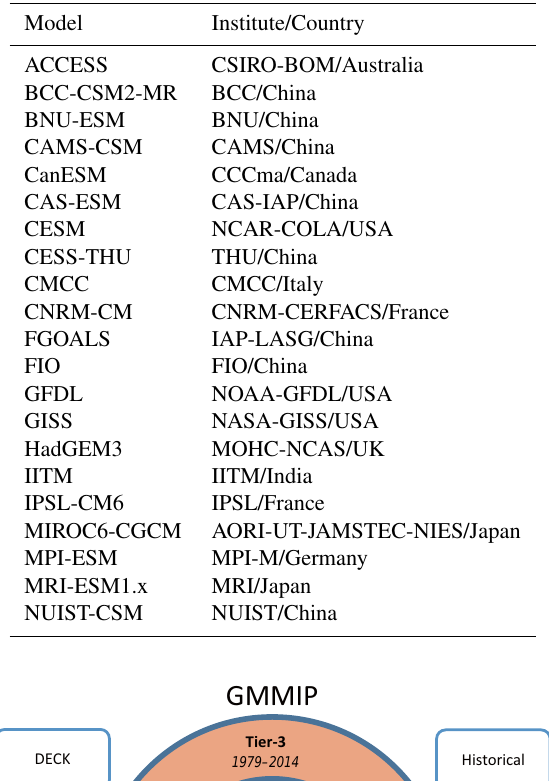
Table 1. Description of models participating GMMIP.